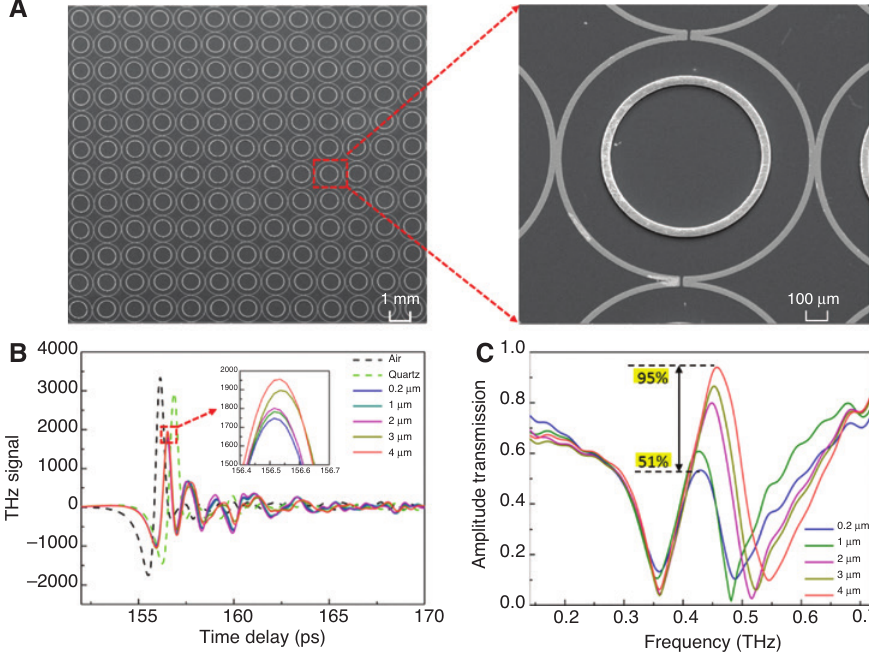
Figure 7: Manufactured sample. (A) Electron microscopy images of the sample ( h 1 = 4 μ m). (B) Original time domain data of TDS with various heights of inner rings. (C) Measured transmission amplitude with various heights of inner